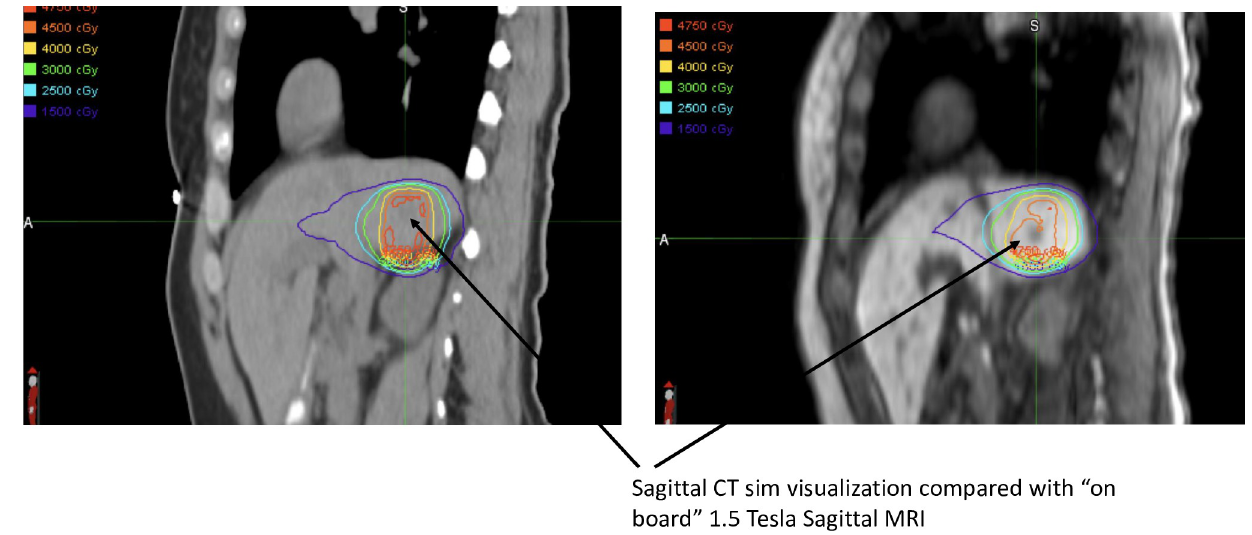
Fig 2. Improved visualization with 1.5 Tesla MRI as compared with CT on rails.